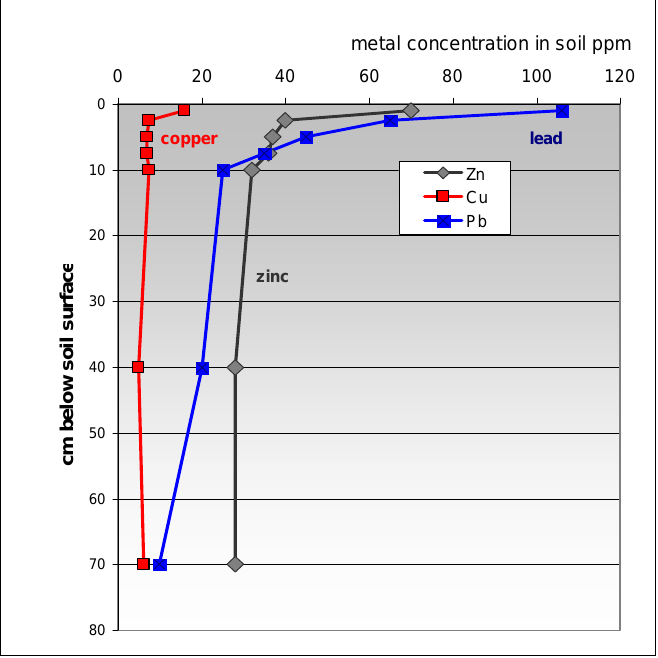
FIGURE 5. Soil profile from a typical beech forest. Zn, Cu, and Pb concentrations (in ppm DM) are decreasing with